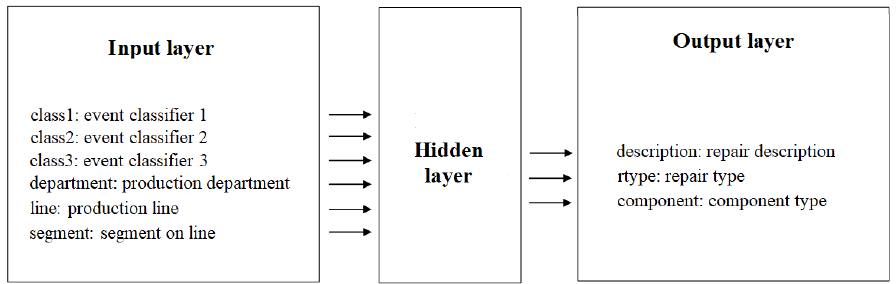
as (Figure 1): corrective maintenance (CM), preventive maintenance (PM) and predictive maintenance (PdM), extended from the condition-based maintenance [19–21].